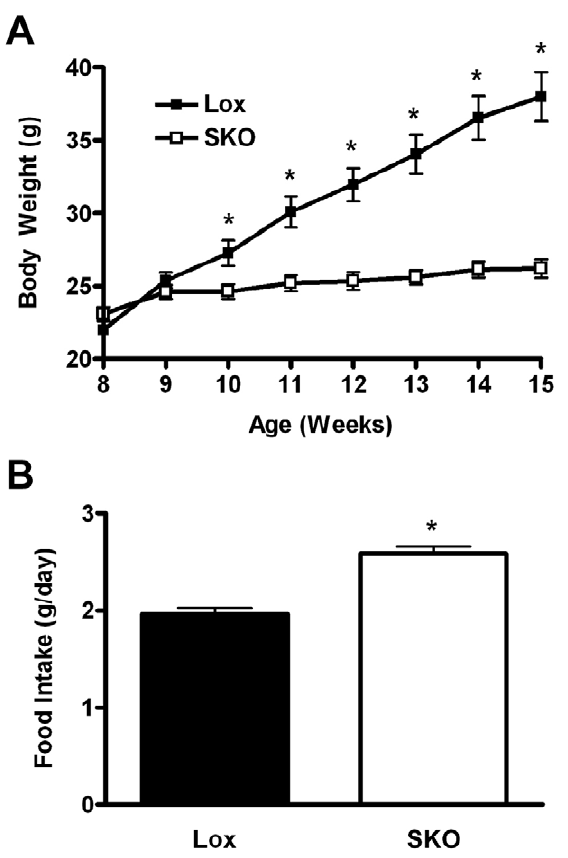
Figure 1. SKO mice remain resistant to obesity in a thermo- neutral environment. Male Lox and SKO mice (n=9–10) were transferred at 6 weeks of age to a controlled environment (32.5–33.5 u C; 30–40% relative humidity), allowed to acclimate for 2 weeks and then fed a high-fat diet (Harlan TD.06414; 60% kcal fat) for 7 weeks. A) Body weight curve; B) Food intake. Data represent mean 6 SEM. *, p ,